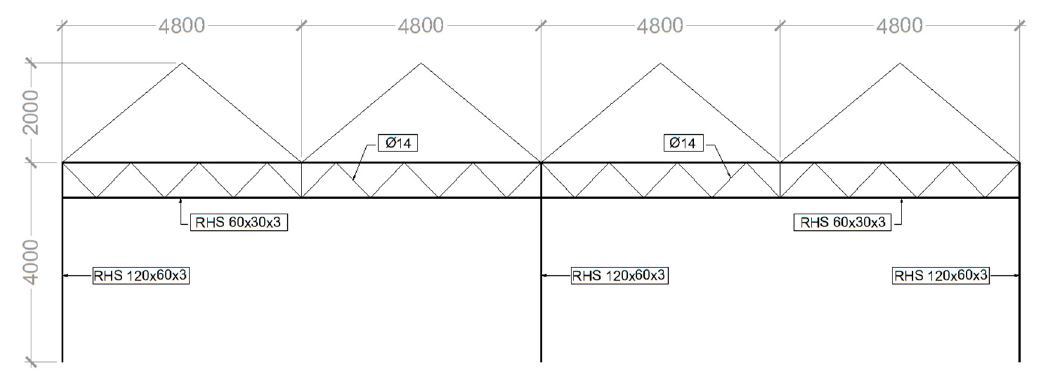
Figure 10. Typical frame of Venlo-type greenhouse [15].